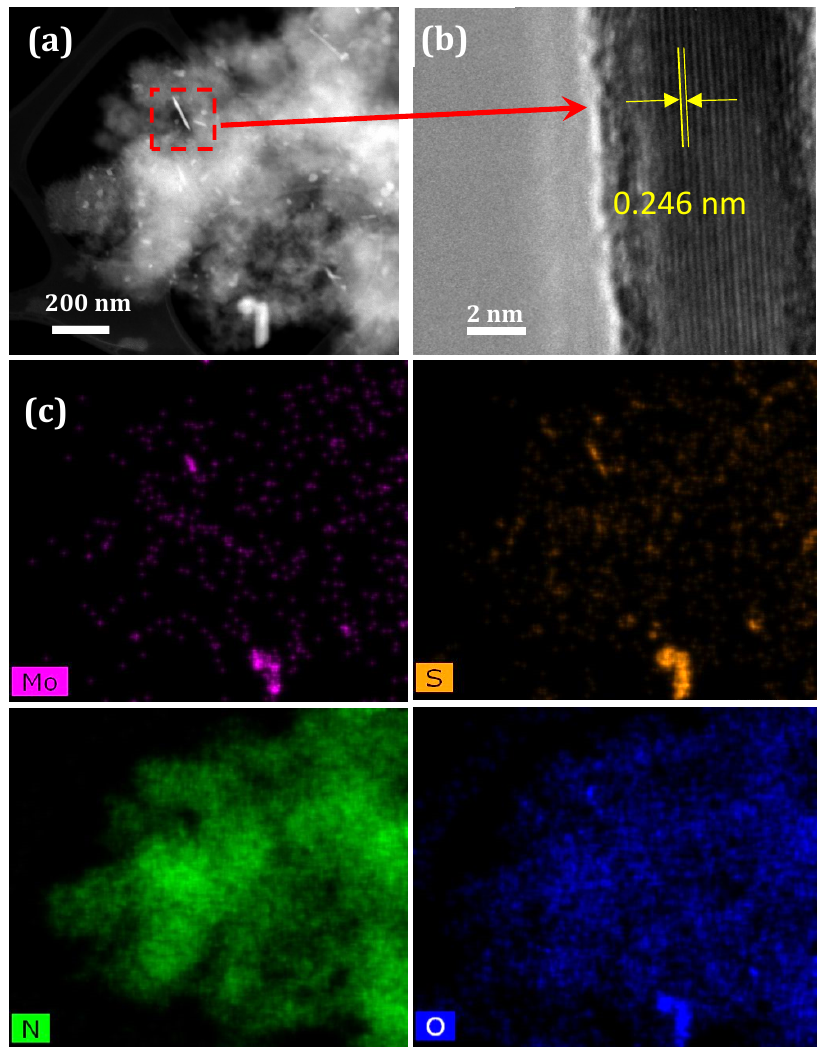
Figure 3. HAADF-STEM ( a ) and HRTEM ( b ) images with corresponding EDXS elemental maps ( c )